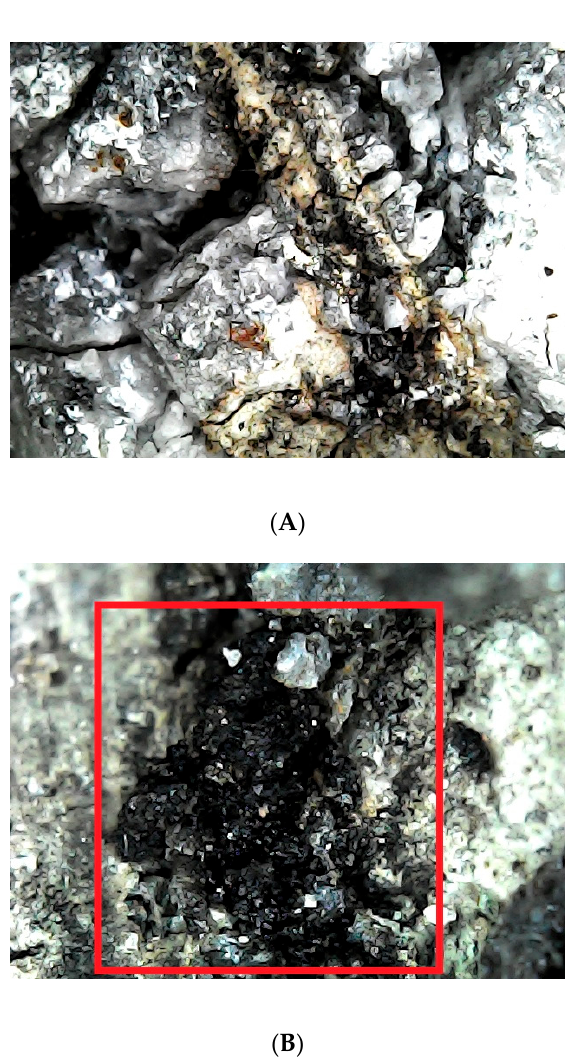
Figure 8. ( A ) Cavities that are not filled with modified asphalt. ( B ) Filler which fills the voids between the aggregates.